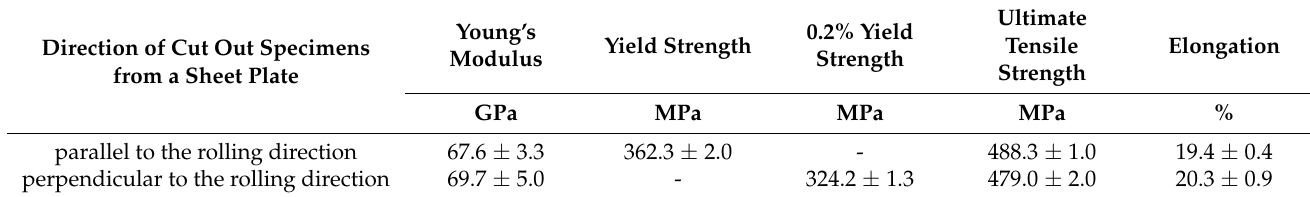
Table 4. Monotonic properties of the 2024-T3 alloy in the form of 0.16” thick sheet plate.